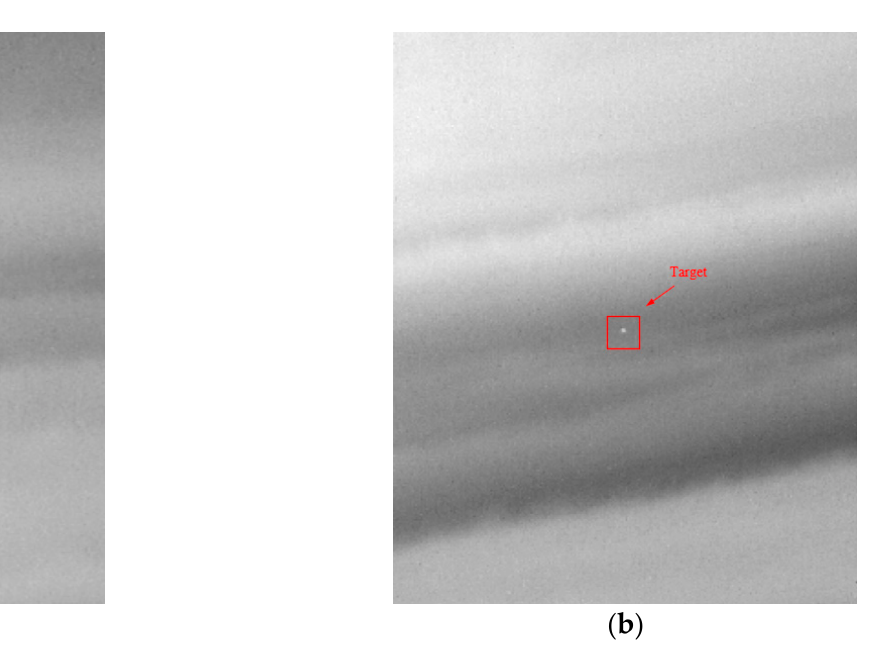
Figure 25. Flight experiment detect small and weak targets with application of image correction coefficients: ( a ) without filter; ( b ) with filter.